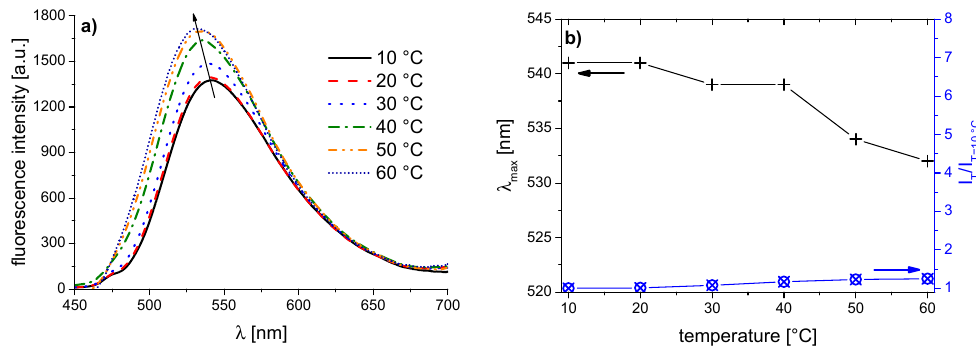
Figure 11. Temperature dependent fluorescence behavior of PNVCL-g in aqueous solution (concentration 0.10 g·L − 1 ): ( a ) normalized emission spectra ( λ Exc = 409 nm); and ( b ) evolution of λ maxEm of the emission band, and of the fluorescence intensity normalized to 10 °C.